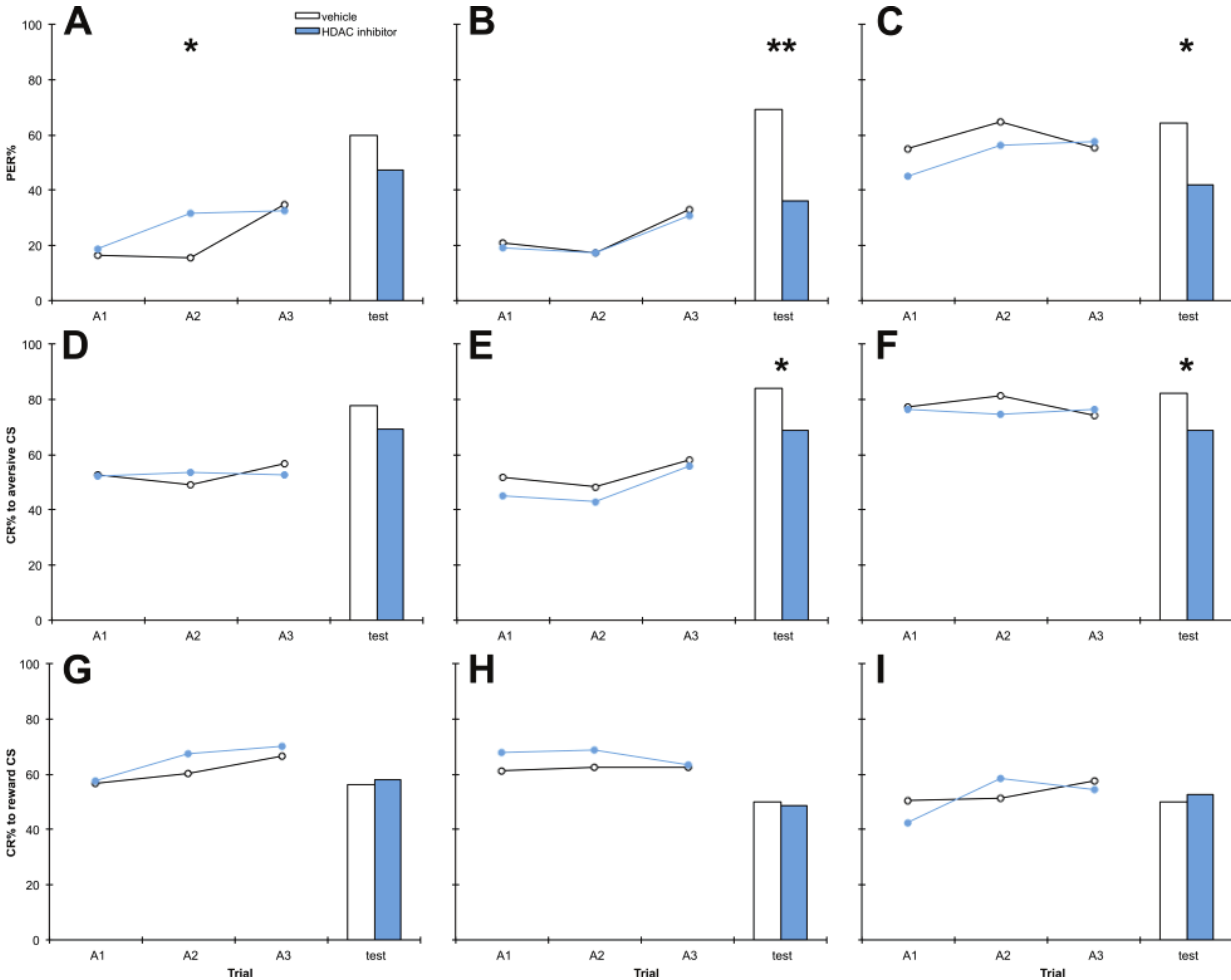
Figure 1. The histone deacetylase (HDAC) inhibitor compound 8 (C8) impairs aversive memory at test at doses 10 mM or greater. Bees were treated with 1 mM ( A , D , G ), 10 mM ( B , E , H ) or 20 mM ( C , F , I ) C8 or vehicle only, 1 h after training. Panels A – C show discrimination learning and memory, panels D – F show aversive learning and memory and panels G – I show reward learning and memory, during acquisition training (A1,A2,A3) and at the retention test. 1 mM: n C8 = 124, n vehicle = 89; 10 mM: n C8 = 80, n vehicle =